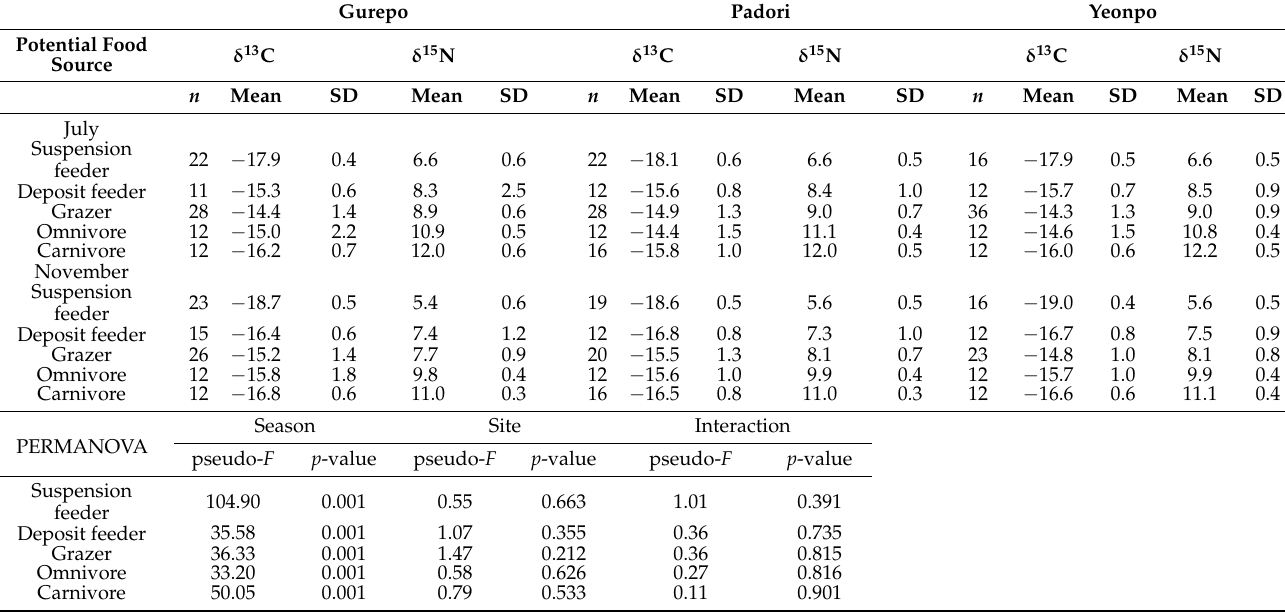
Table 3. Mean δ 13 C and δ 15 N values of consumer feeding groups (suspension feeder, deposit feeder, grazer, omnivore, carnivore) at the two heavily oil-impacted (Gurepo and Padori) and one non- impacted reference (Yeonpo) sites in July and November. PERMANOVA test of δ 13 C and δ 15 N values for each consumer feeding group among the three sites and between the two seasons (significance at p < 0.05). Data represent means ± 1 SD. Gurepo Padori Yeonpo